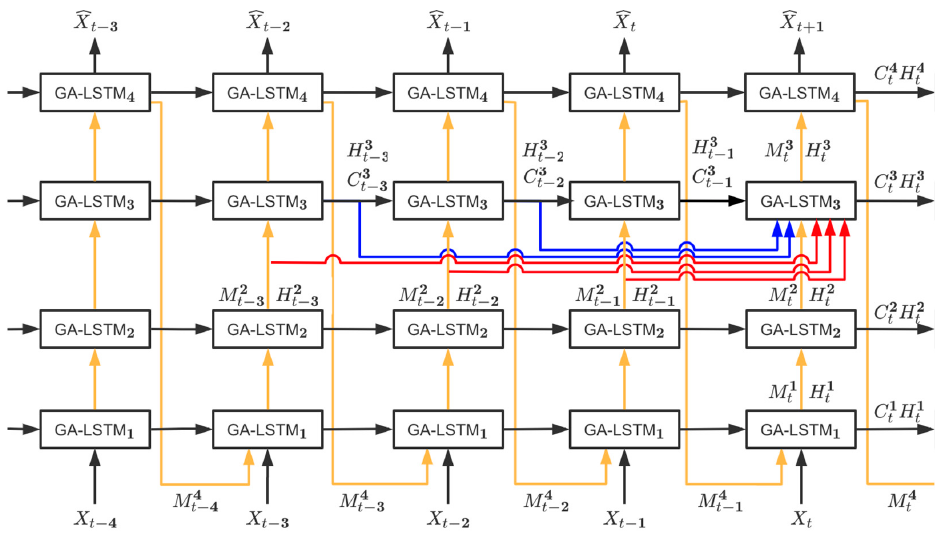
Figure 7. The main architecture of GARNN.